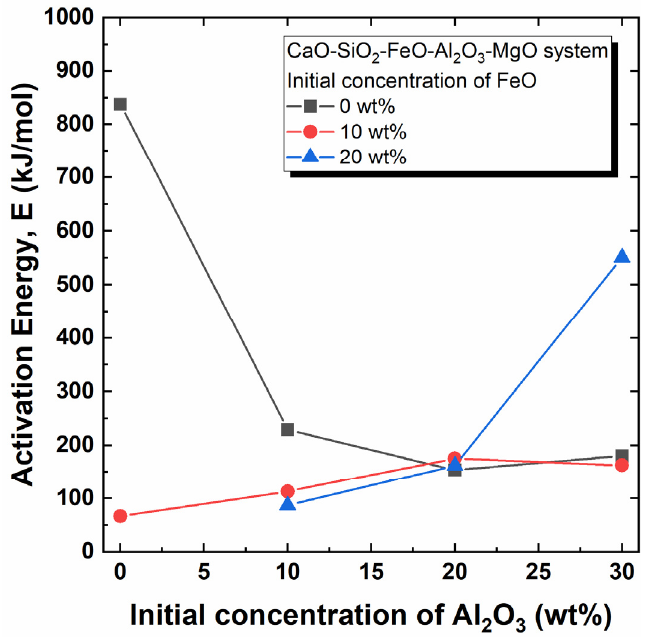
Figure 3. Activation energies of CaO–SiO 2 –FeO–Al 2 O 3 –MgO slag system with varying FeO and Al 2 O 3 concentrations.